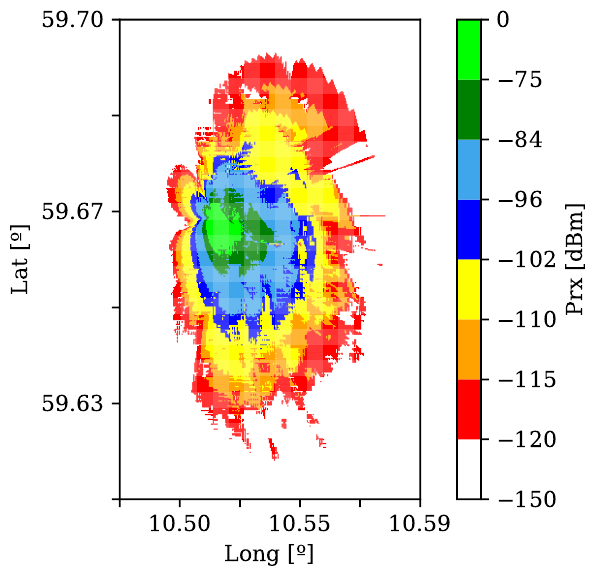
Figure 10. Estimated coverage area of the considered scenario for a MIMO system with a BER of 10 − 4 when using the third iteration of IB-DFE receivers, based on coverage estimation with DTs for a SISO